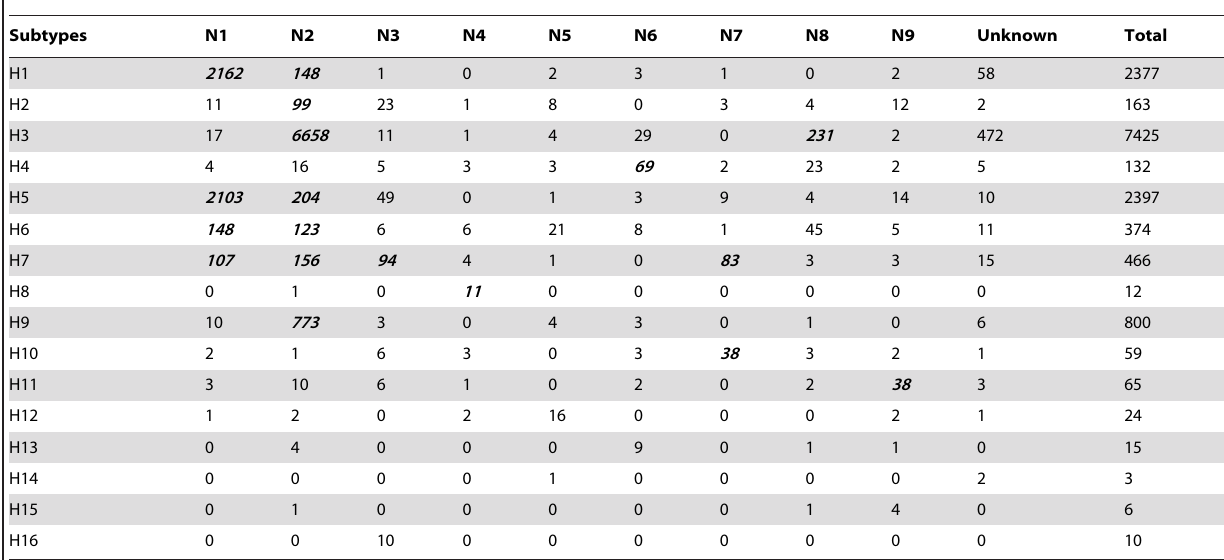
Table 1. NA-subtype distribution of 14328 influenza A viruses with HA sequences in GenBank*.